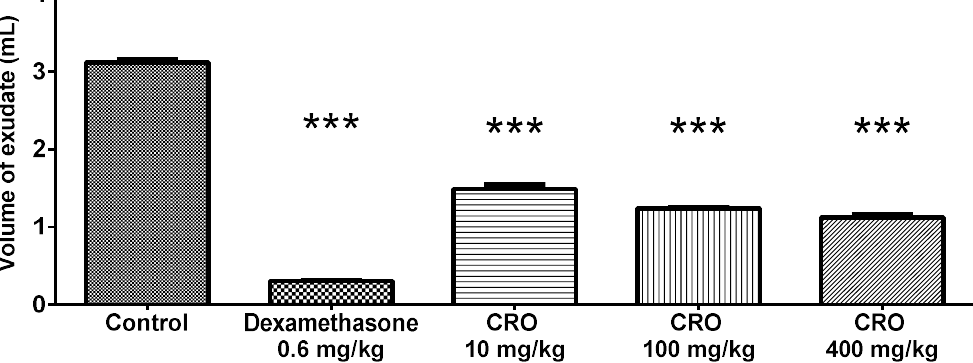
Figure 2. Volume of exudate produced in the air pouch. Effect of C. reticulata oleoresin—CRO (10, 100, and 400 mg/kg, orally) and dexamethasone (0.6 mg/kg, orally) on Wistar rats using the air pouch model. Each point represents the mean ± SE of a group of 5 animals. *** p < 0.001 compared to control (vehicle); one-way ANOVA, Newman–Keuls multiple comparison test.